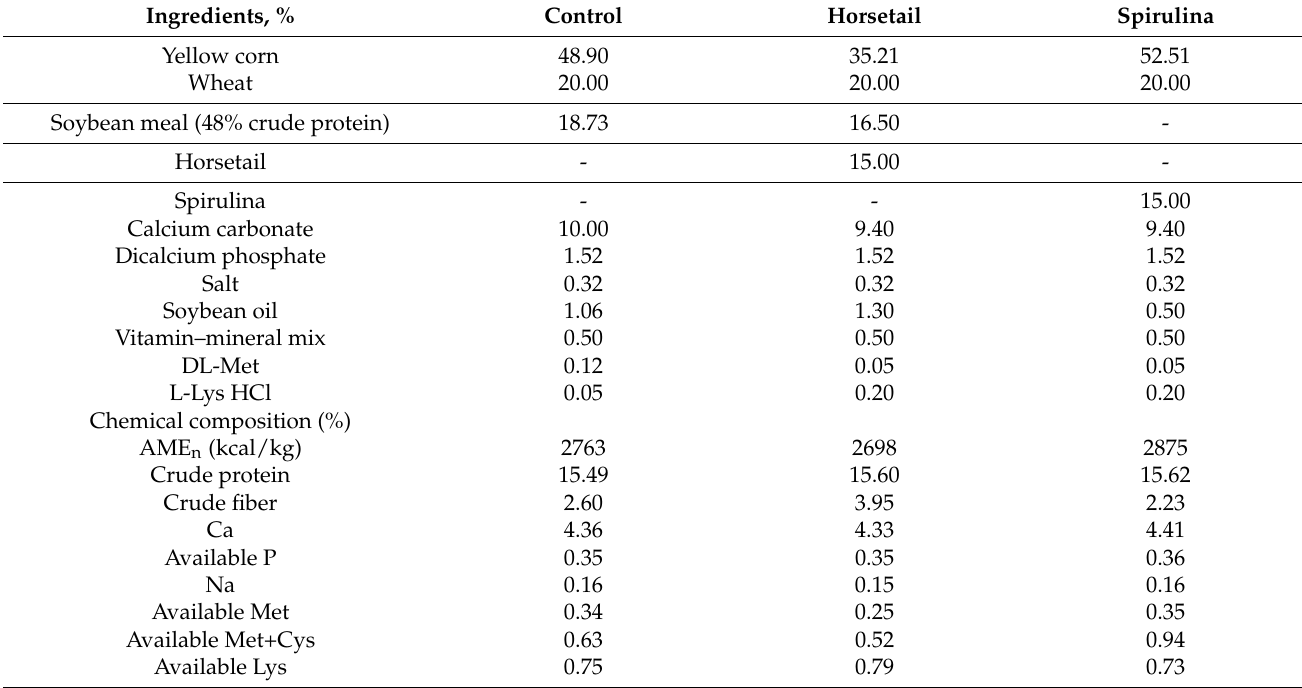
Table 1. The ingredients and nutritional composition of basal-diets.